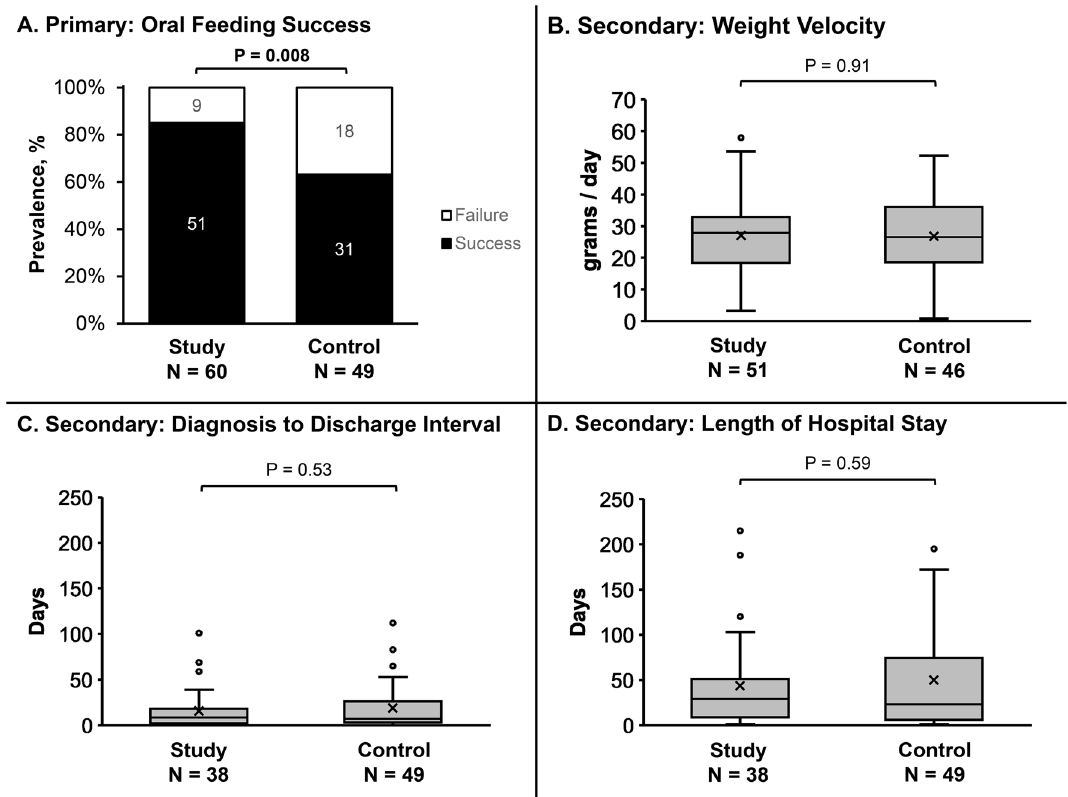
Figure 2. Clinical Outcomes of Infants referred for VFSS (Study Approach: VFSS + HRIM + Parent Preference) and Control (standard-of-care: VFSS informed). On the boxplots, X ’s represents the mean while dots represent outliers. Primary clinical outcome success was greater in the study group ( A ). Secondary outcomes did not significantly differ ( B – D ). In figures ( C , D ), there were 22 infants in the study group studied as outpatients and discharged the same day, hence not included in the N